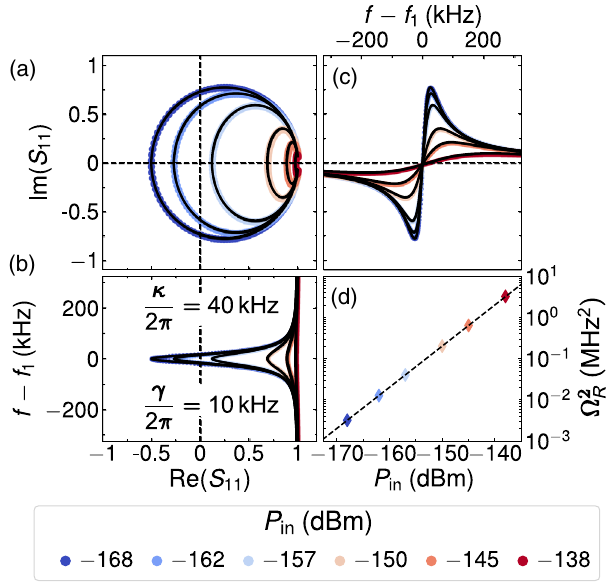
FIG. 9. Numerical simulations of resonance fluorescence. Complex reflection coefficient S 11 (a), its real part (b), and imaginary part (c), numerically calculated for probe frequencies f around the resonance frequency f 1 ¼ 7 . 4887 GHz of the Kerr Hamiltonian in Eq. (D1). For comparison, the input drive power P , the Kerr coefficient K ¼ 2 π × 4 . 5 MHz, and the decay rates in γ ¼ 2 π × 10 kHz and κ ¼ 2 π × 40 kHz are set to be the same as in the experiment. The black lines indicate least-squares fits using Eq. (1). The only fit parameter is the Rabi frequency Ω in (d). The linear dependence of the Rabi frequency with drive amplitude and the quantitative agreement with the measured data shown in Fig. 2(d) confirm the validity of the qubit limit and the value of the input line attenuation A ¼ 103 dB.